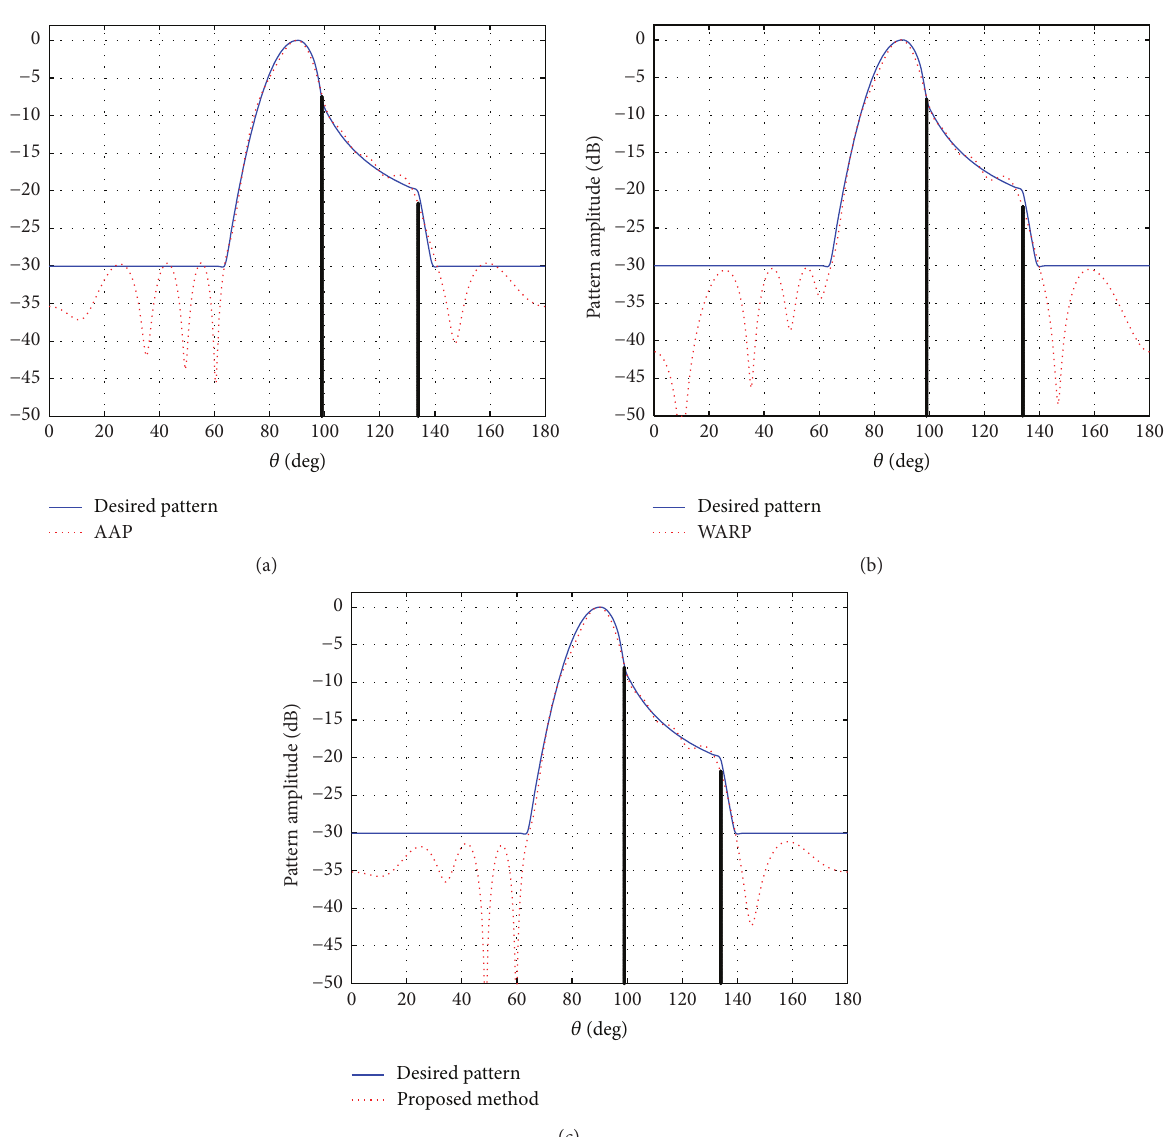
Figure 3: Pattern of CSP synthesis. (a) AAP method, (b) WARP method, and (c) proposed method.